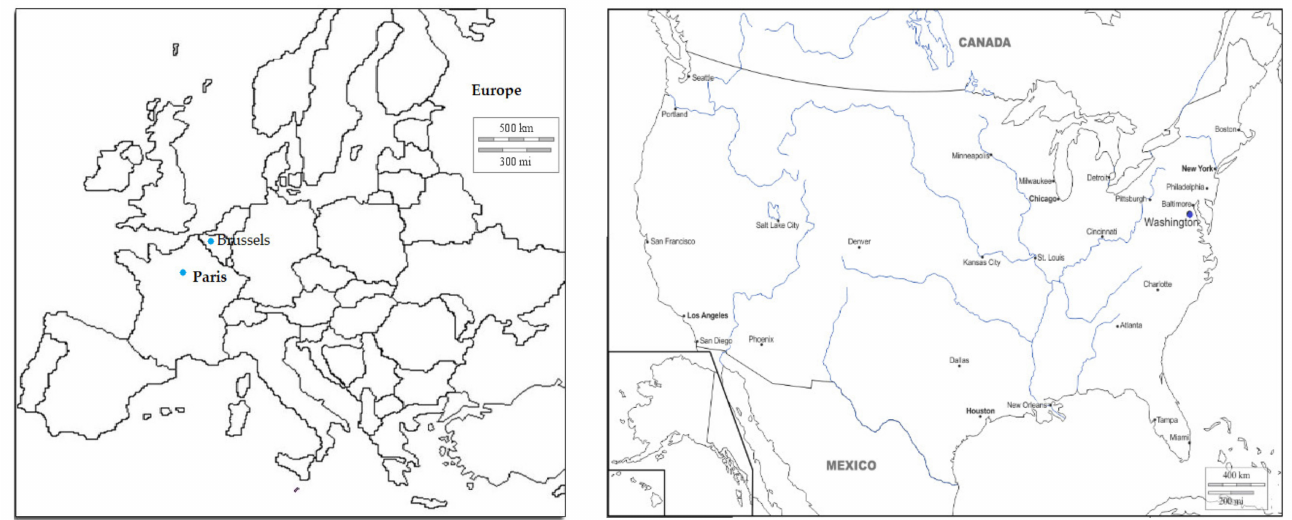
Figure 3. Location of Brussels and Paris ( on right ) and Washington DC ( on left